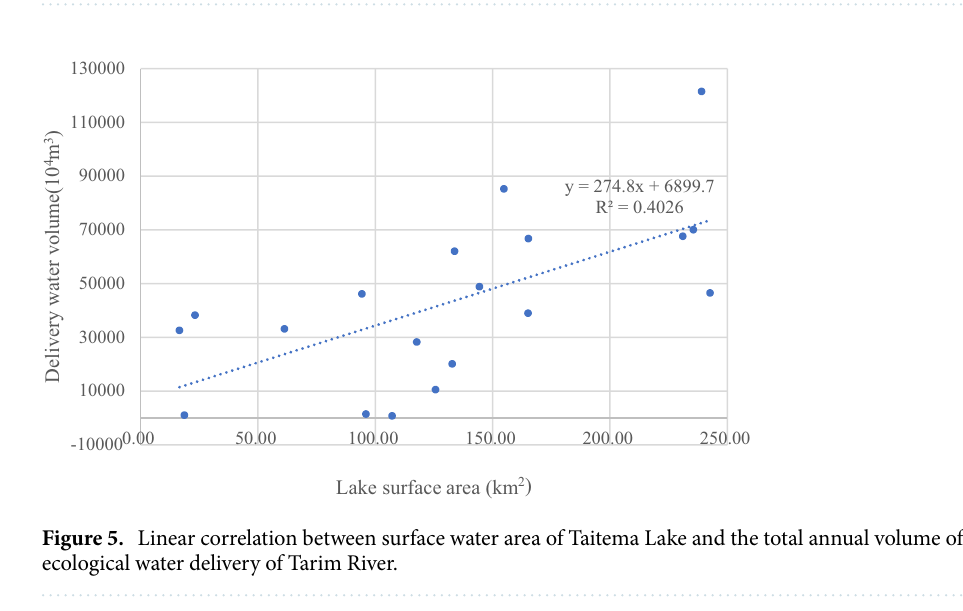
Table 5. Ecological water delivery number, data, volume, and water head reached area of the Tarim River (Wang and Tursun, 2020).